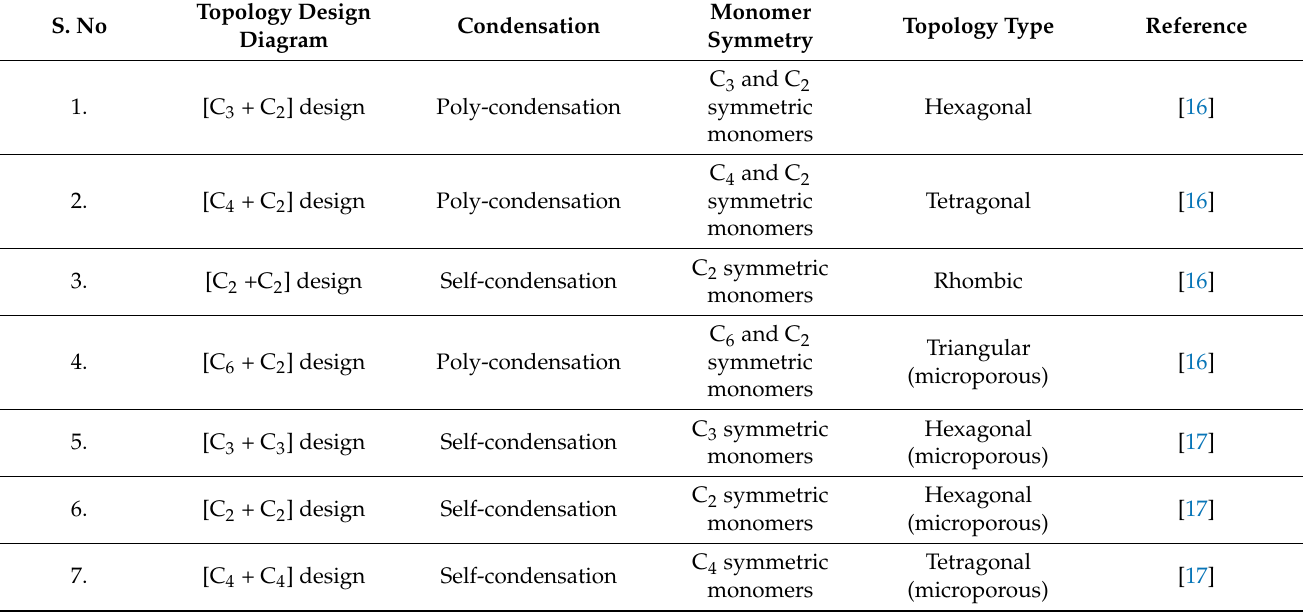
Table 1. Topology design diagram, condensation type, topology type and monomer symmetry of recently reported